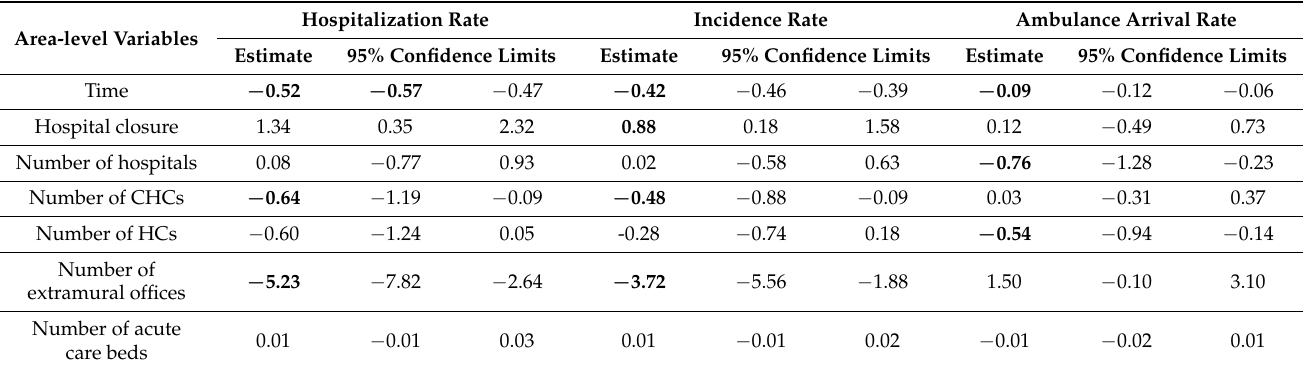
Table 3. Ecological regression